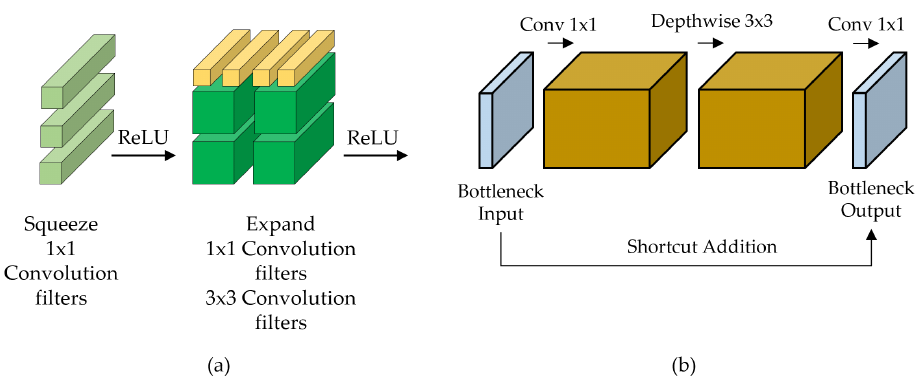
Figure 6. Building blocks of SqueezeNet and MobileNetV2: ( a ) Fire module of SqueezeNet with three 1 × 1 convolutional filters in the squeeze layer, four 1 × 1 convolutional filters in the expand layer, and four 3 × 3 convolutional filters in the expand layer; ( b ) Bottleneck depthwise separable convolution with residuals, which is a basic building block of MobileNetV2. This figure represents the block where stride =